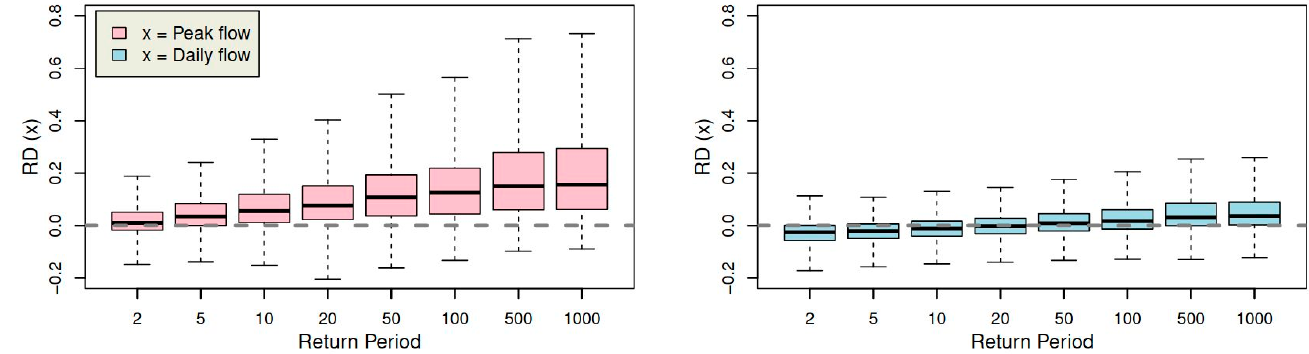
Figure 9. Relative difference for quantiles of different return periods.